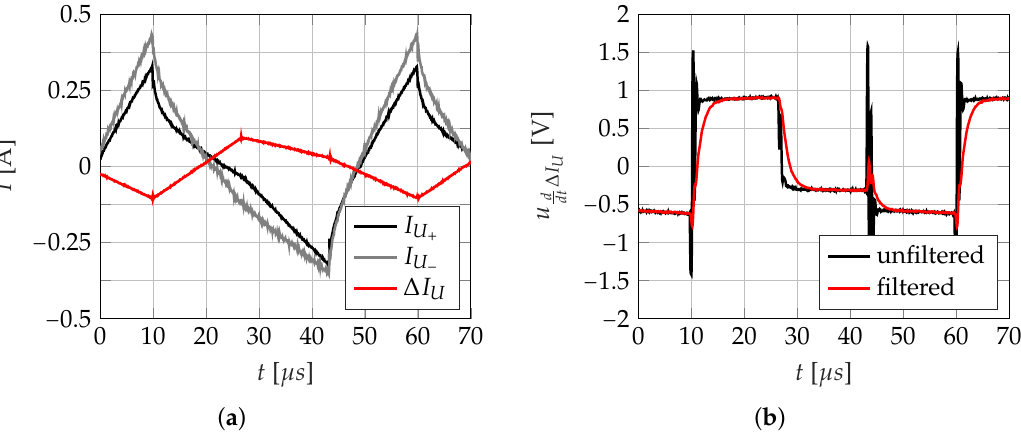
Figure 3. ( a ) Current ripple of the actuator coils. The influence of eddy currents is mostly suppressed in the differential current signal ∆ I U ( f PWM = 20 kHz, U DC = 60 V). ( b ) Output signal of the open loop transformer corresponding to ( a ). The output voltage is proportional to the differential current slope.